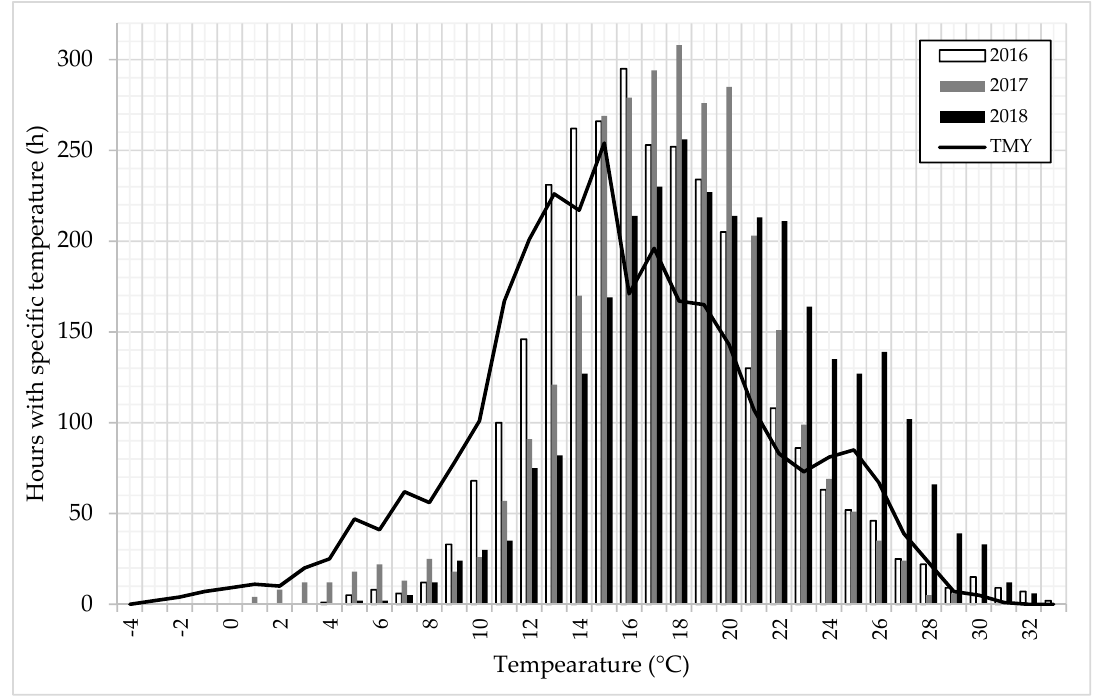
Figure 3. Distribution of outdoor air temperature in the analyzed period. Total solar irradiance (TSI) in the analyzed period was determined at 515,867 W/m 2 based on